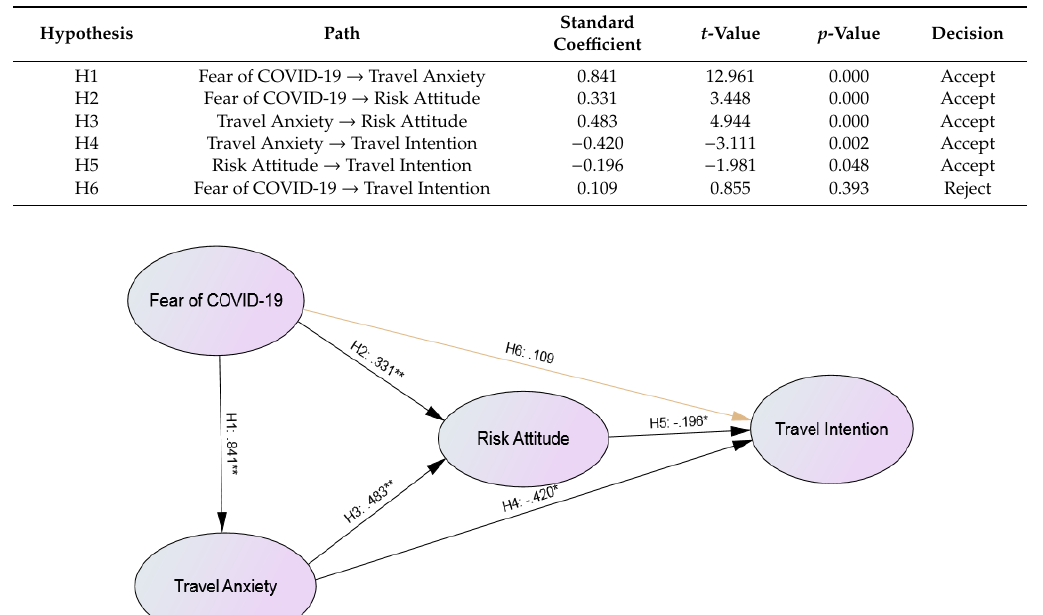
Figure 1 . Results of the Hypotheses (Note: ** p value < 0.01; * p value < 0.05).